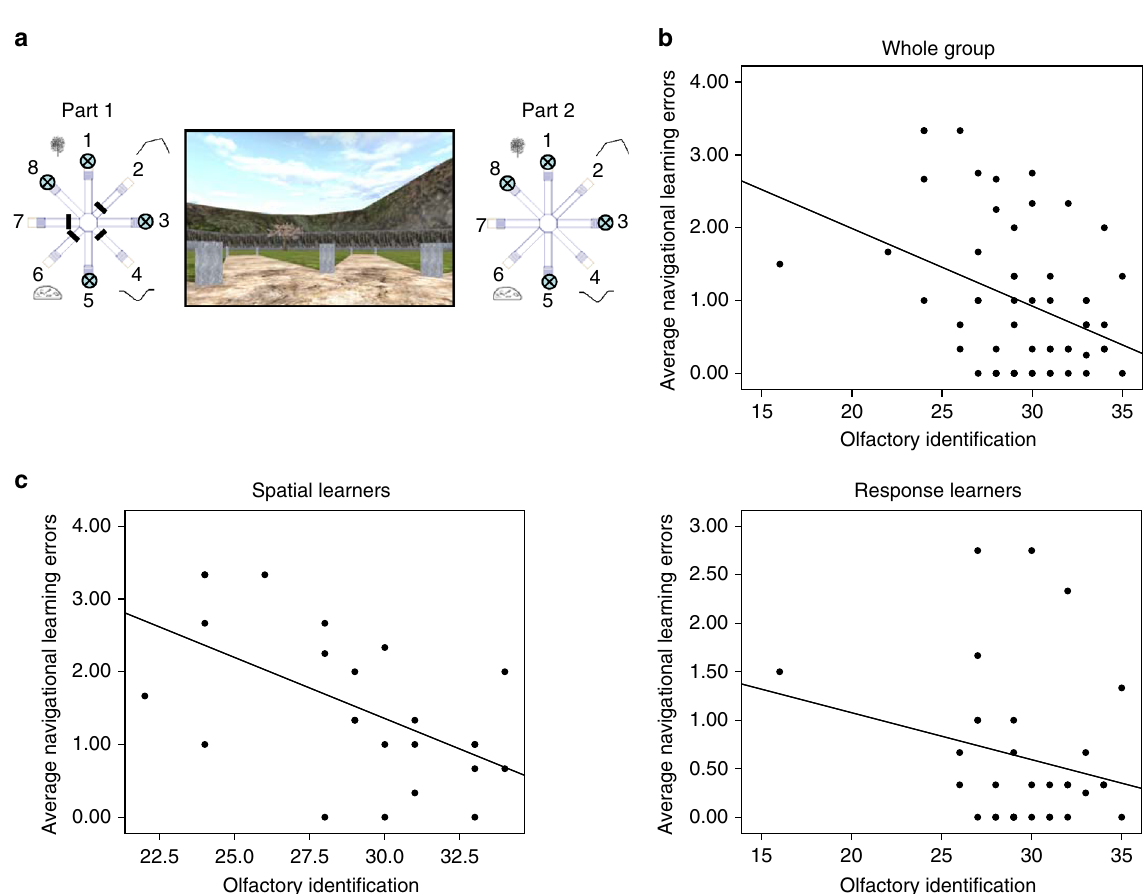
Fig. 2 Olfactory identi fi cation correlates with spatial memory. a The 4-on-8 Virtual Maze (4/8 VM) consists in an 8-arm radial maze surrounded by landmarks. In Part 1, four of the paths are blocked and four are open. Participants have to retrieve objects at the end of the open paths. In Part 2, the barriers are removed. Participants have to avoid the paths they visited in Part 1 to retrieve the remaining objects. They can learn the object locations using a spatial memory strategy (e.g., “ the path is to the left of the boulder ” ) or a stimulus-response strategy ( “ From the starting position, I have to take the path straight ahead and then skip a path on the right ” ). Once participants learn the task to criterion, they are taken to a probe stage, where a wall is raised around the maze which hides the landmarks. People who used a spatial memory strategy during learning ('spatial learners') make more errors than people who used a stimulus-response strategy ('response learners'), as they can no longer use landmarks to fi nd the target paths. At the end of the task, participants complete a verbal report, which serves to determine the strategy they used as well as the number of landmarks they used (e.g., “ I used the rock and the tree to fi nd the objects ” ) and noticed (e.g., “ I saw a mountain but I did not use it ” ). b There was a negative correlation between olfactory identi fi cation and the average number of navigational errors made in Part 2 of the learning trials ( r = − 0.37, Bootstrap BCa 95% CI [ − 0.52, − 0.21]). c When we looked within navigation strategies, we found that this effect was driven by spatial learners (left) ( r = − 0.57, Bootstrap BCa 95% CI [ − 0.77, − 0.33]), while response learners did not show such a relationship (right) ( r = − 0.22, Bootstrap BCa 95% CI [ − 0.49, 0.14]). Thus, it appears that the